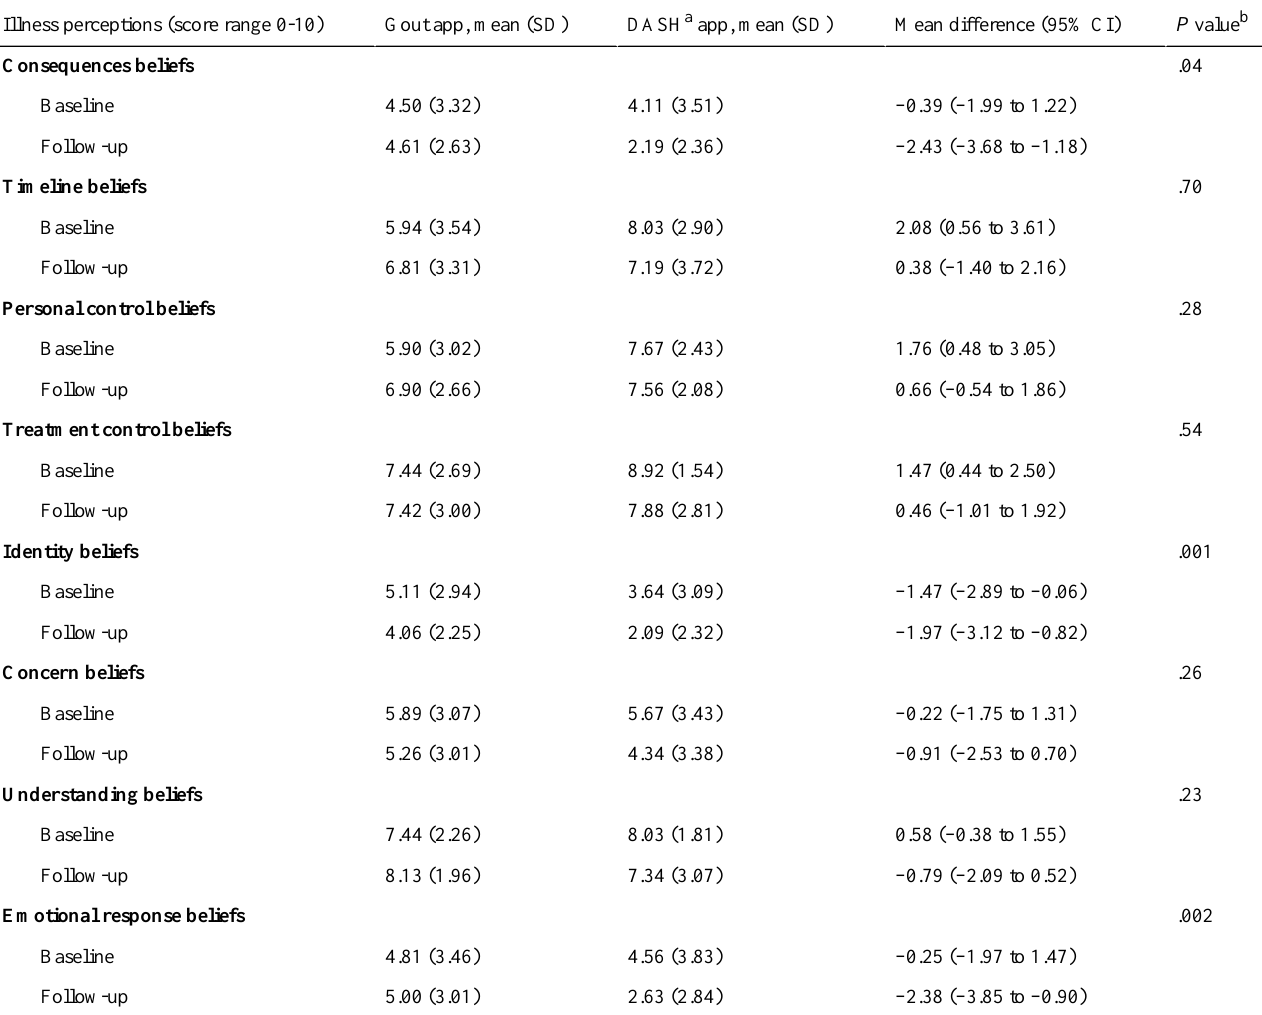
Table 2. Mean differences in illness perceptions at baseline and